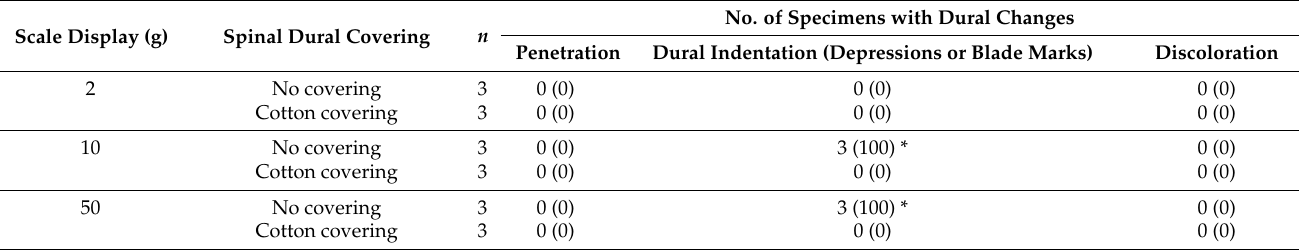
Table 2. Changes in the dura mater from the ultrasonic bone curette pressing the spinal cord without ultrasonic oscillation (electron microscopy and